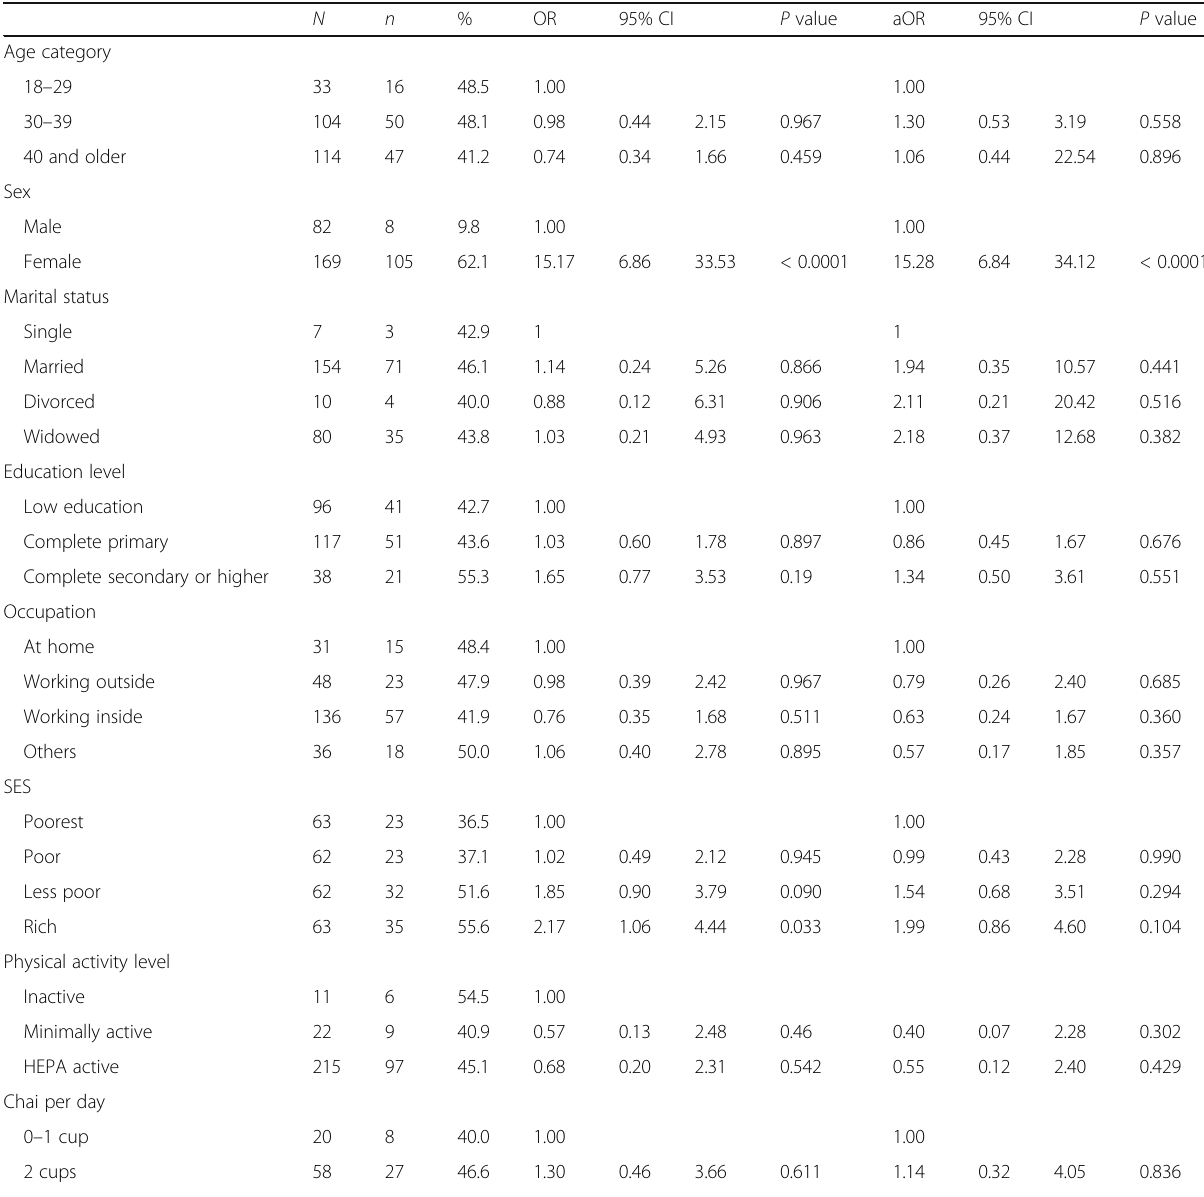
Table 4 Factors associated with abdominal